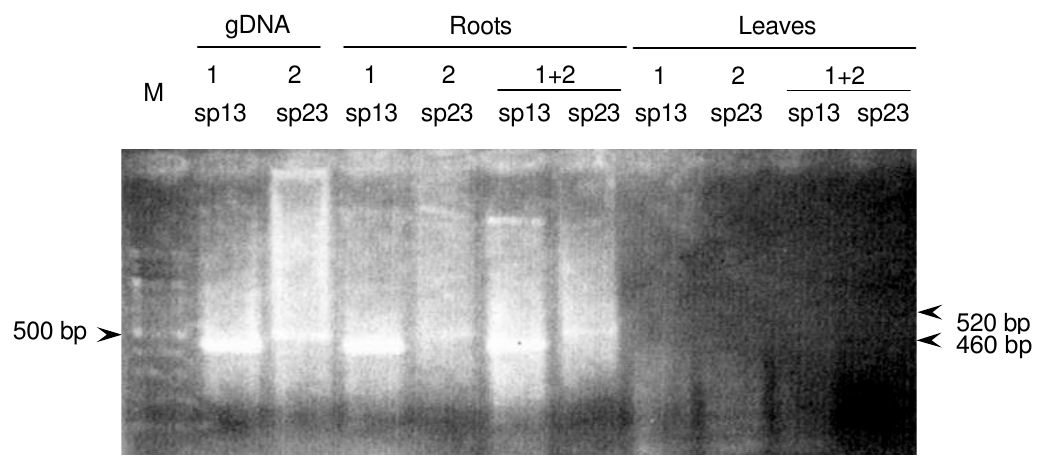
Fig. 9. Detection of Fusarium oxysporum f. sp. lycopersici race 1 and race 2 from tomato cv. Ponderosa tissues 24